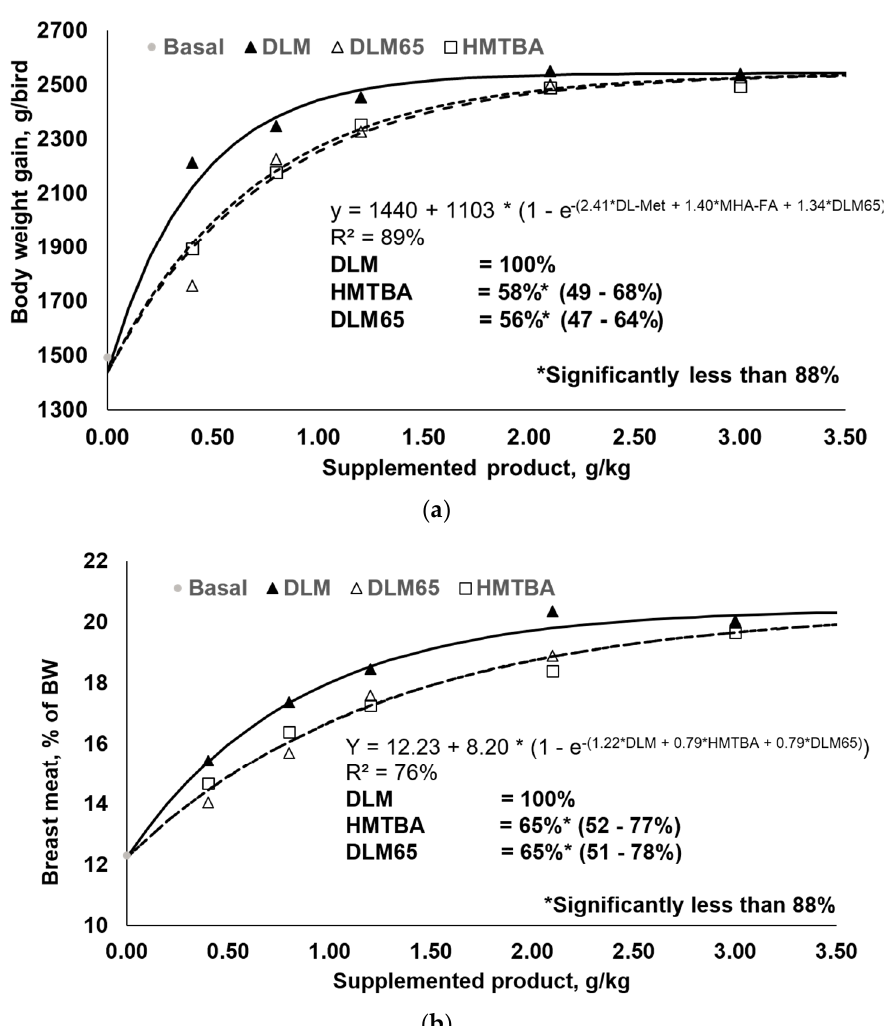
Figure 1. Body weight gain ( a ) and breast meat yield (% of body weight) responses ( b ) of 0–35 day old broilers to graded levels of DL-2-hydroxy-4-methylthio butanoic acid (HMTBA), or to 65% purity diluted DLM (DLM65) relative to DL-Methionine (DLM).